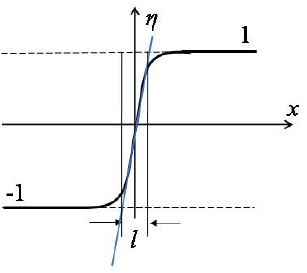
Figure 1. Schematic phase field profile across the interface.